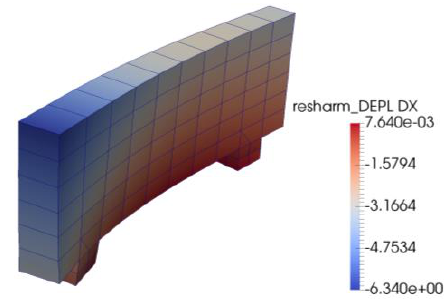
Fig. 13. Displacement of the flap at t